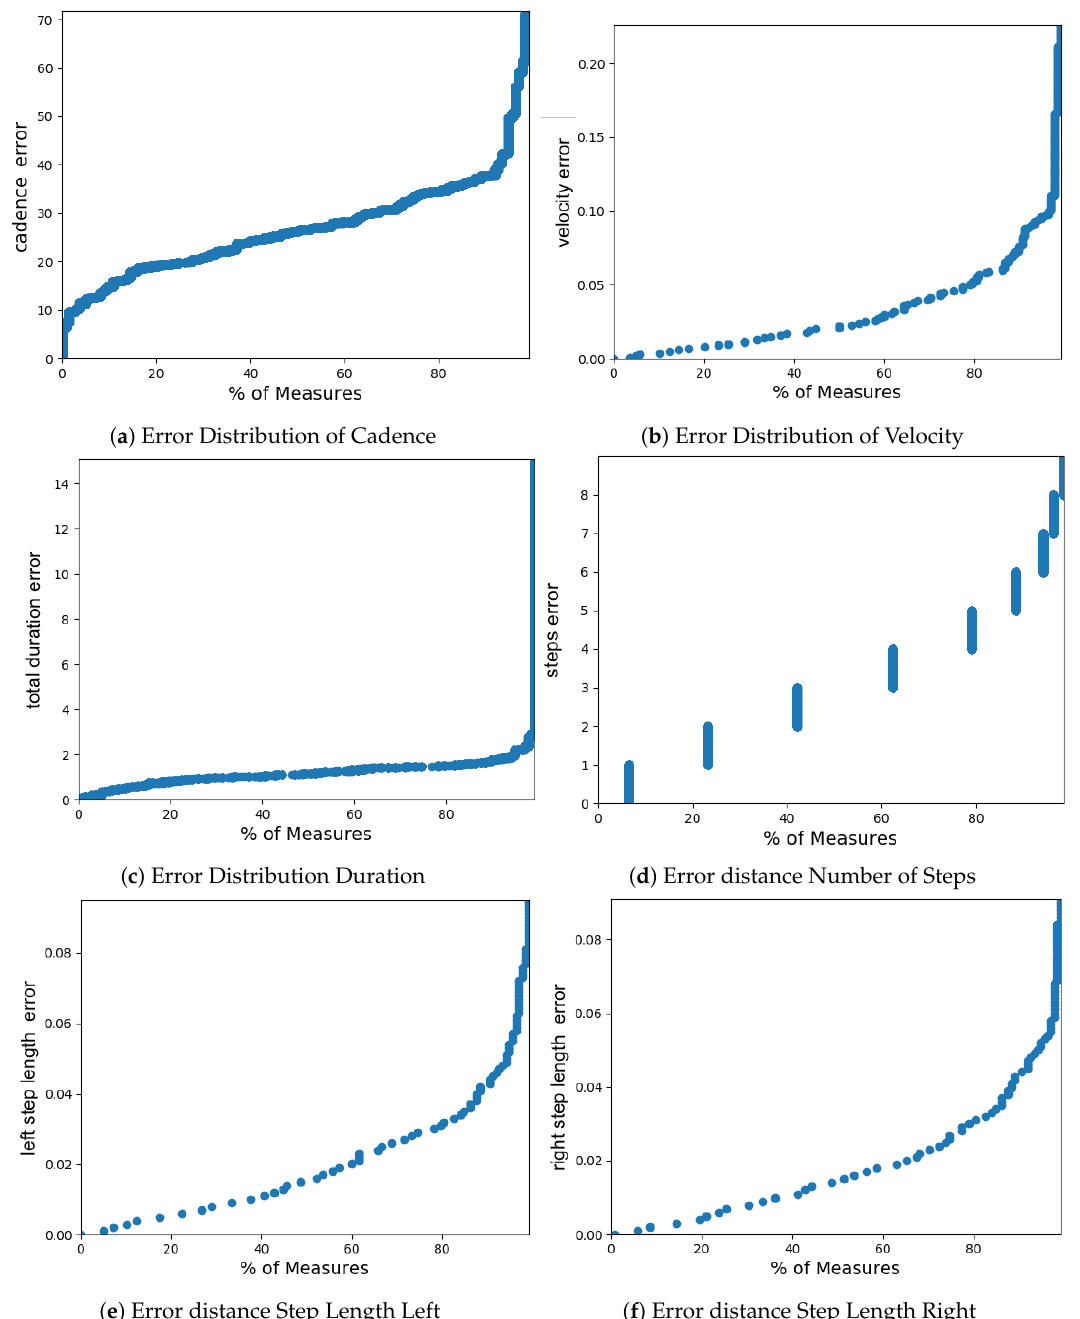
Figure 3. Error Distributions of Spatio-Temporal